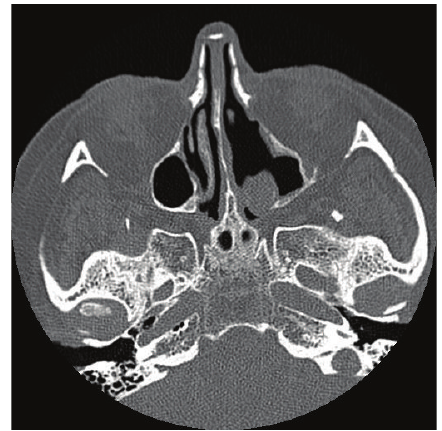
Figure 2: CT scan taken in 2007 showing evidence of surgery in the patient’s left nasal cavity. The lesion has been removed, and the maxillary ostium is